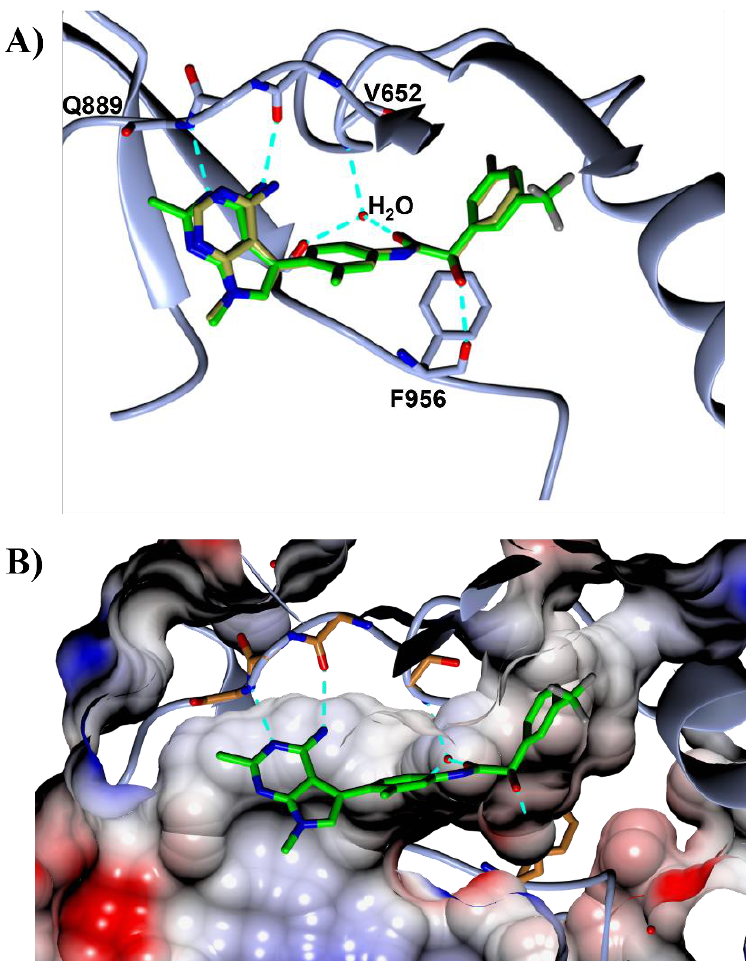
exposure levels following administration (Figure 5C).